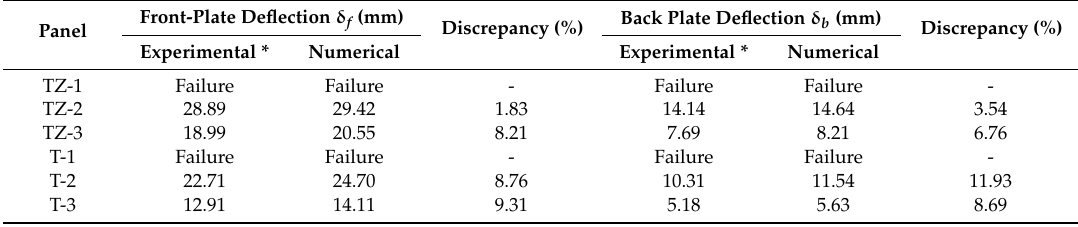
Table 5. Experimental and numerical